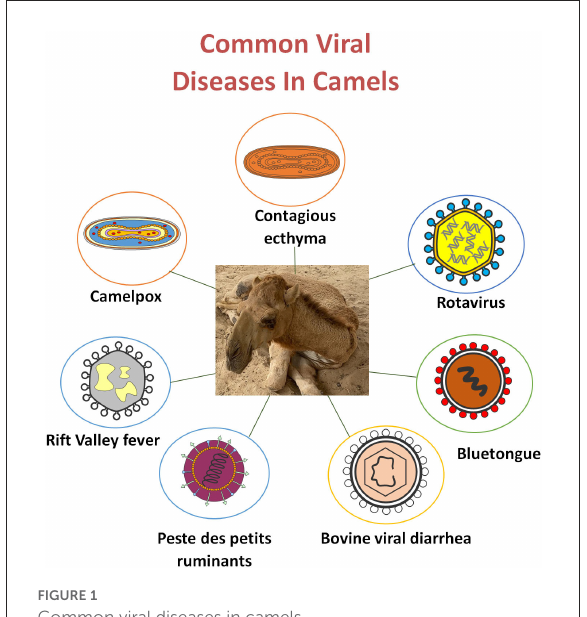
FIGURE1 Common viral diseases in